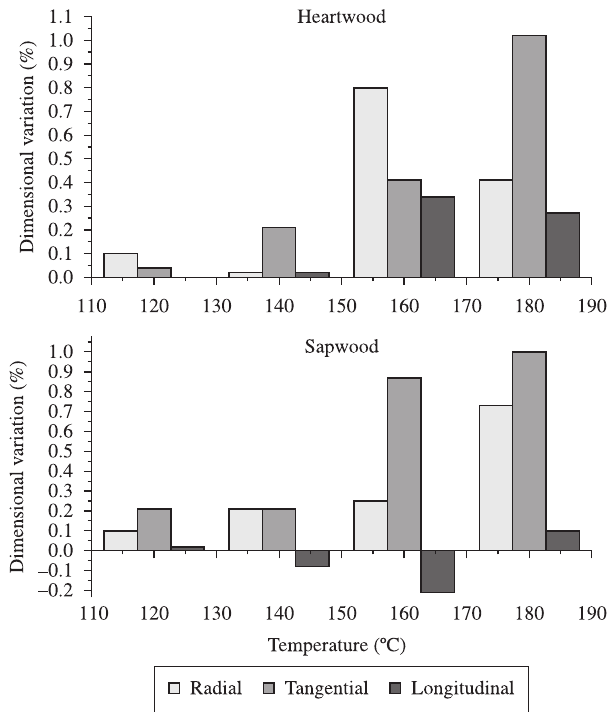
Figure 3. Dimensional variation with temperature for Araucaria angustifolia (sapwood and heartwood) at different growth directions.